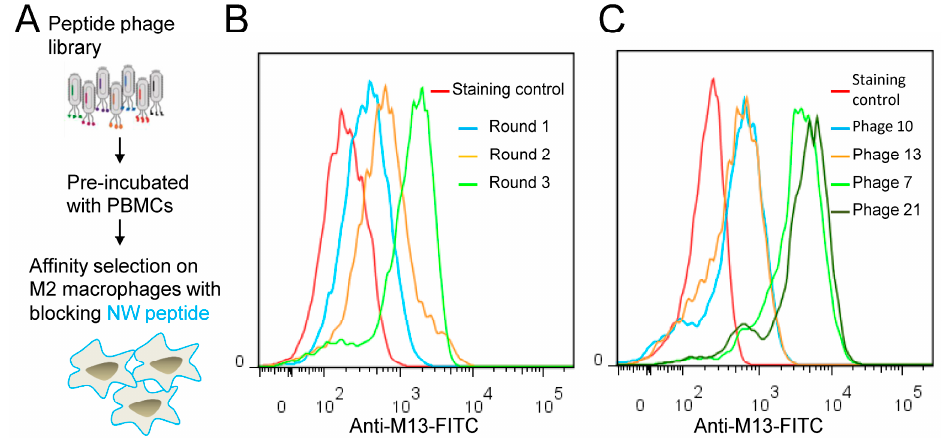
Figure 5. Selection on target cells with blocking NW peptide. ( A ) Schematic illustration of peptide blocking strategy. The peptide phage library was pre-incubated with non-target cells and then affinity selected on M2 macrophages with NW peptide blocking. ( B ) Binding of the enriched phage pool from round 1, 2 and 3 to M2 macrophages. ( C ) Representative examples of binding patterns of single phage clones to M2 macrophages. Cells were incubated with single phage clones (10 7 TU/mL) followed by FITC-conjugated anti-M13 monoclonal antibody staining and analysis by flow cytometry.